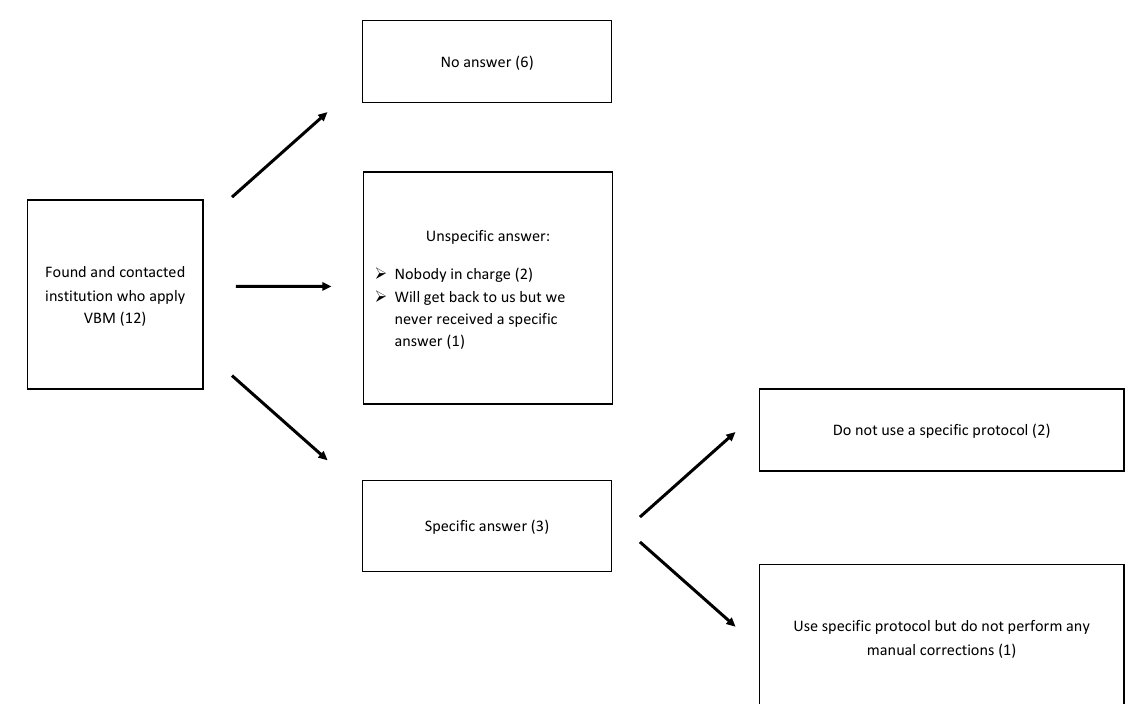
Figure 1. Flow diagram representing type of feedback received from universities and clinics regarding standardized preprocessing protocols in voxel-based morphometry analysis (number of answers in brackets).